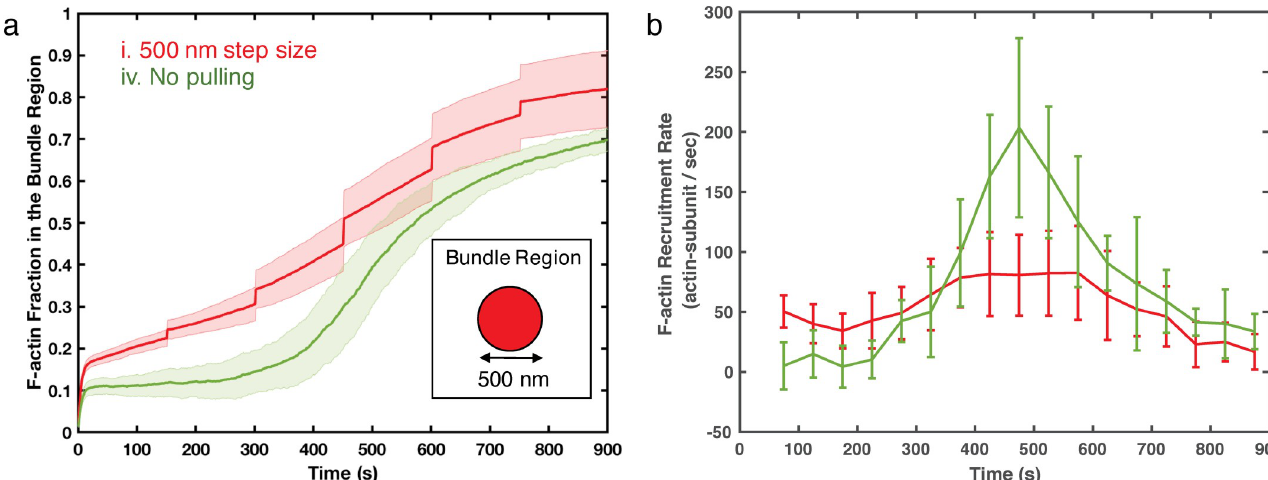
Fig 4. (a) The F-actin fraction in the bundle region as a function of time for actin networks under 500 nm displacement steps (red, Case i) and actin networks free of external force (green, Case iv). The bundle region is defined as the volume under the simulated AFM probe, which is a cylindrical region of 500 nm in diameter and the height of the simulation box. The box size varies over time based on the position of the AFM probe. Insert shows a 2D illustration of the bundle region. (b) The rate of F-actin accumulation in the bundle region from simulations with the AFM probe pulling force (red, Case i) and without AFM probe pulling- force (green, control Case iv). The recruitment rates are calculated by linear-fitting of the data points every 50 seconds. Shaded colors and error bars are the standard deviations of 10 replica simulations for Case i and 5 replicas for Case iv, respectively.